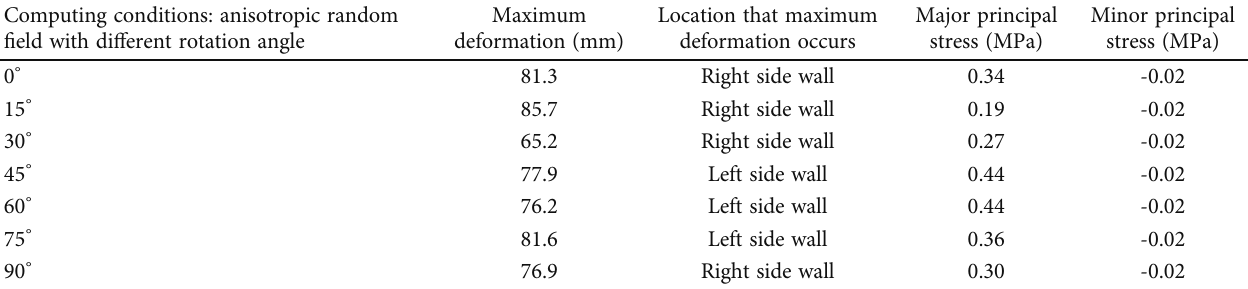
Table 3: Summary and comparison between simulation results with random fi eld with di ff erent rotation angle. Computing conditions: anisotropic random fi eld with di ff erent rotation